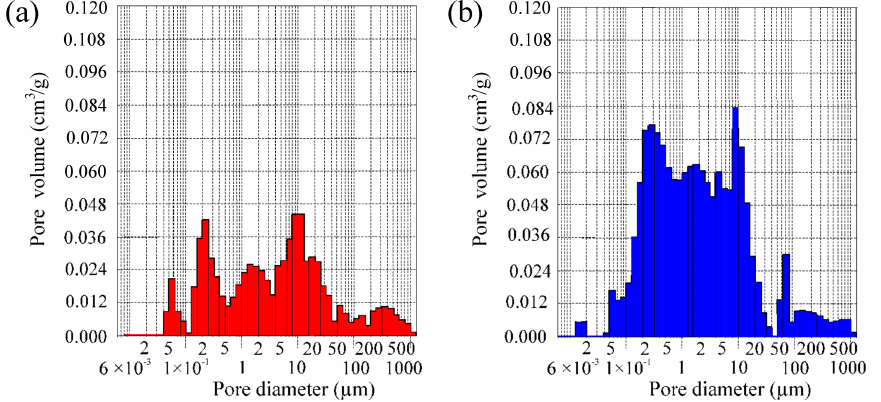
Figure 12. Pore distribution (by volume) in ceramic bodies CS ( a ) and CD20 ( b ) fired at 1060 ◦